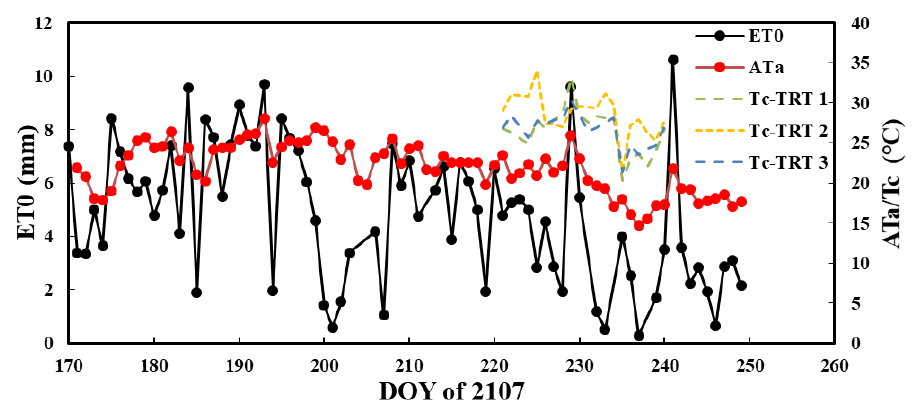
Figure 4. Daily reference evapotranspiration (ET0), average daily air temperature (Ta), and canopy temperature (Tc) during the studied period.